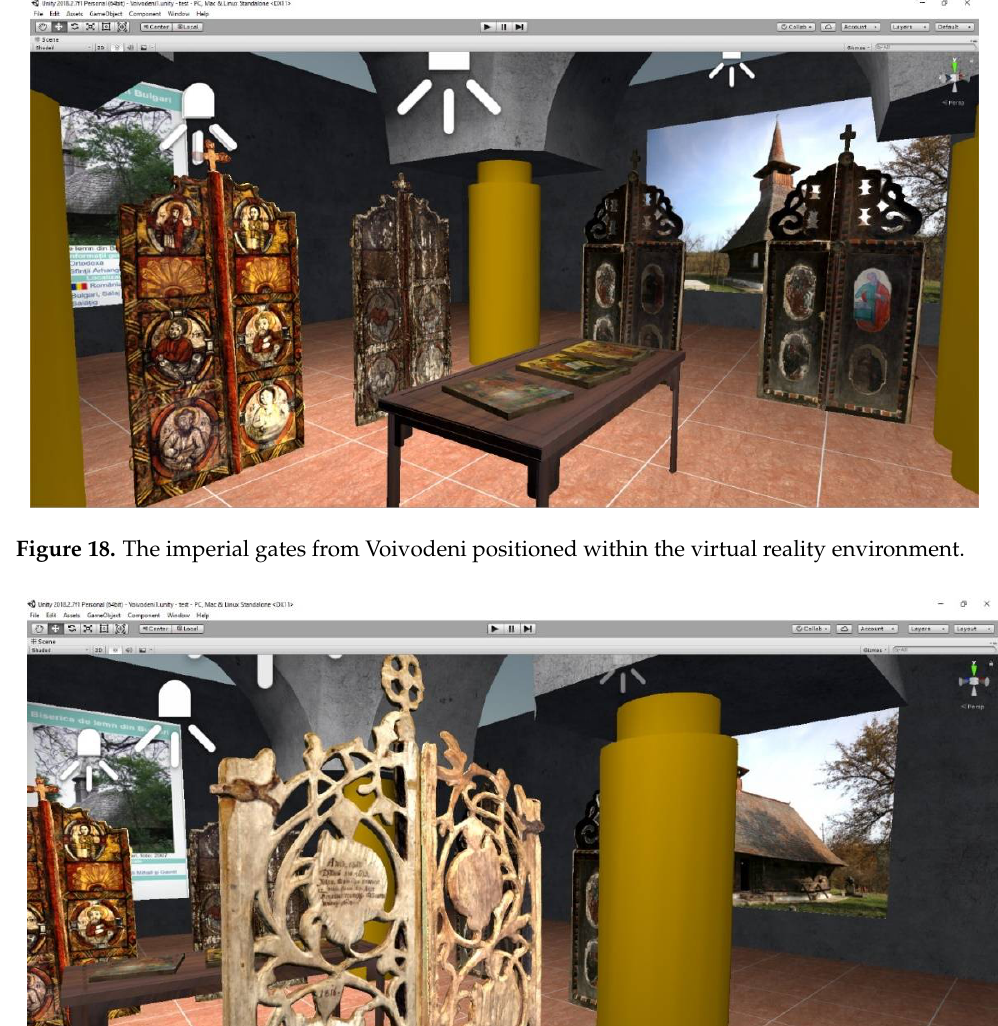
ului, S ă laj County, back ,